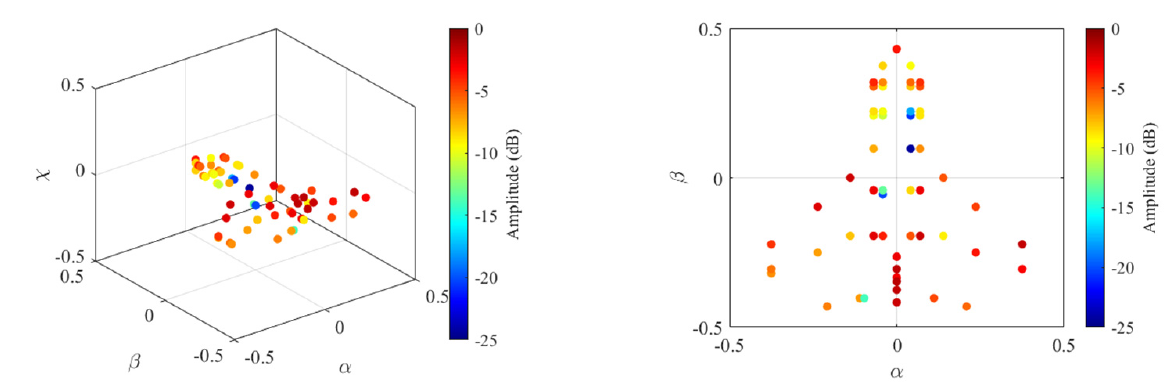
Figure 18. Target imaging result obtained by TSL0 with random sparse-sampled signal cube.